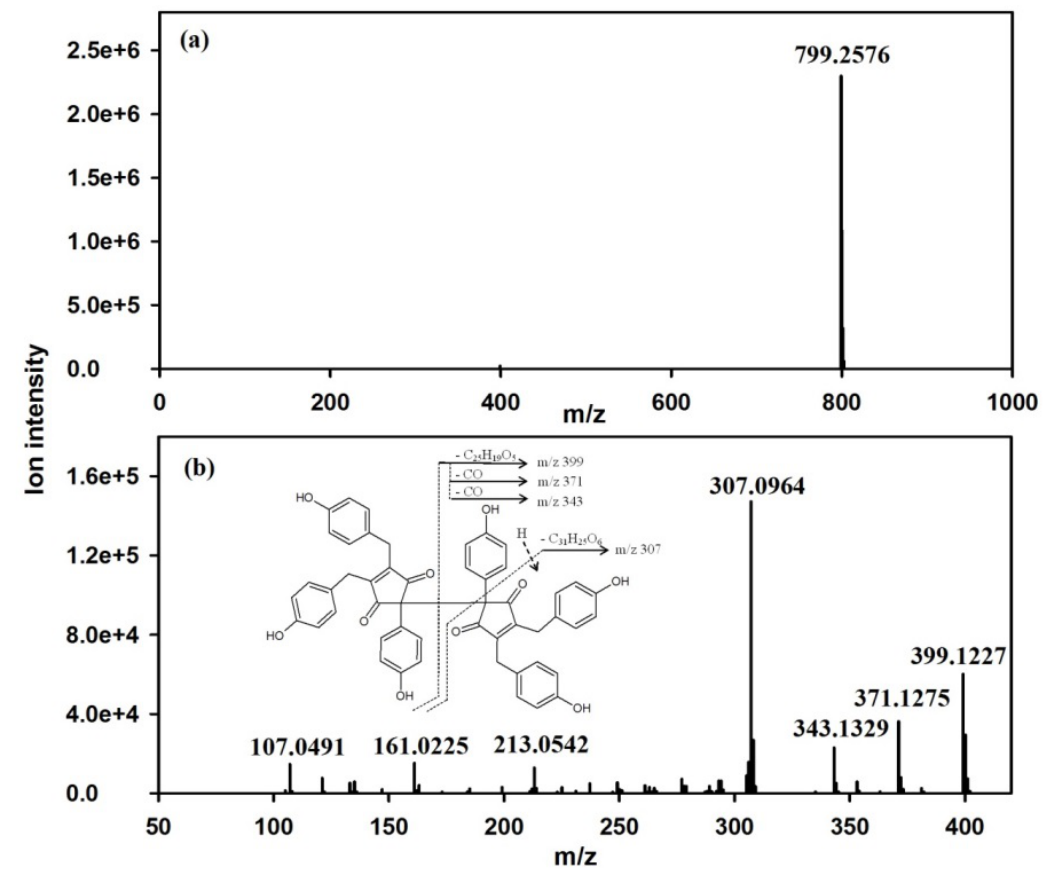
Figure 5. ( a ) Positive-ion mass spectra of NOS-6 fraction obtained by two-step HPCCC separation. ( b ) The MS 2 spectra of the selected ion at m/z 799 corresponding to